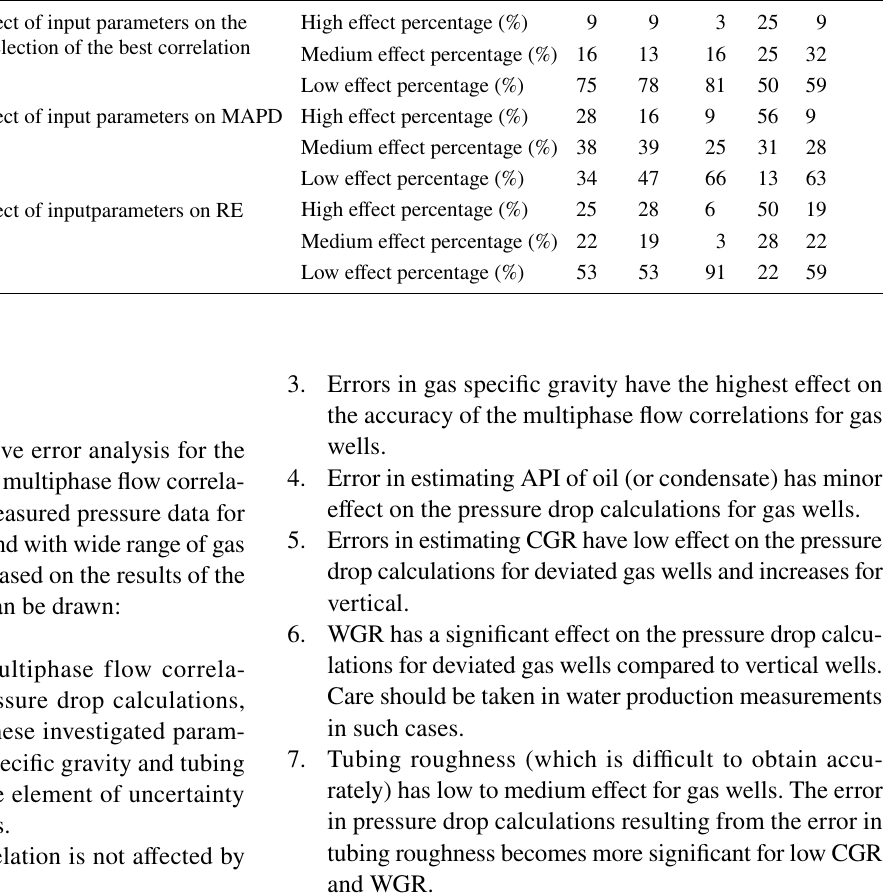
Table 9 Summary results for the effect of input parameters on the selection of the best correlation, MAPD and